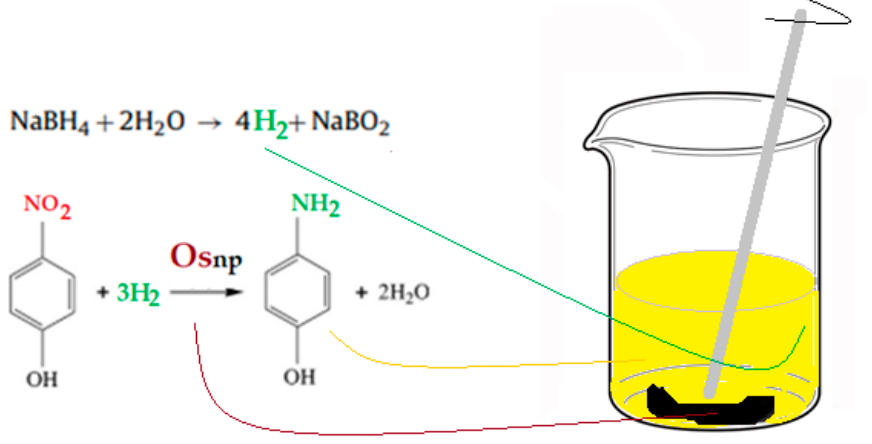
Figure 12. Schematic representation of the reduction processes, with Os–PPM composite membranes. Table 2. Comparative data on the ‘catalytic rate constant ( k )’ for the catalytic reduction processes.